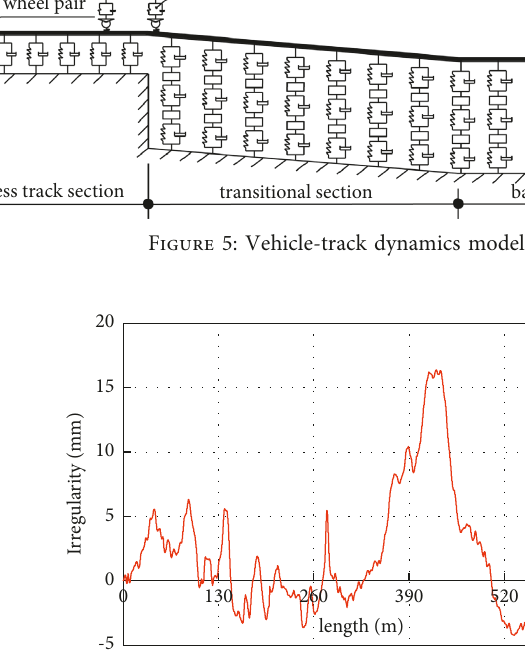
Figure 6: Vertical irregularity of track.